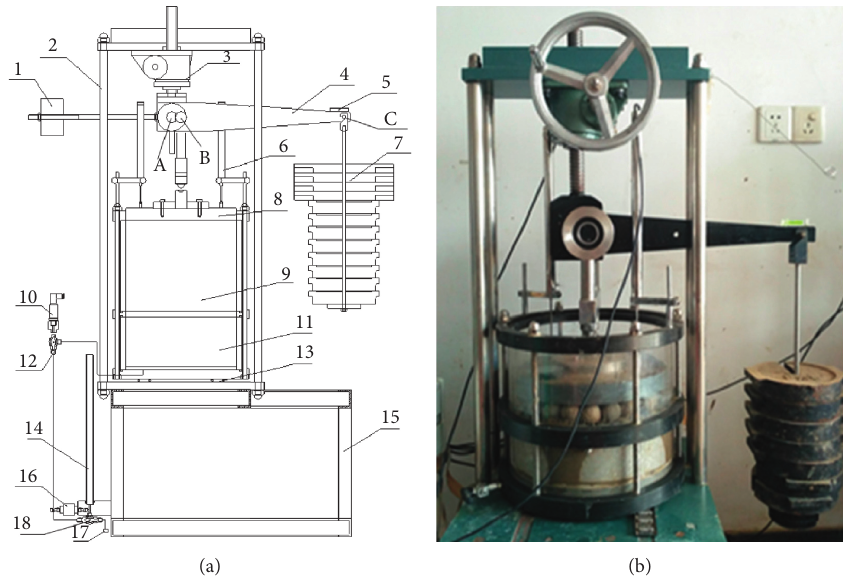
Figure 2: Mutual embedding testing apparatus: (a) design sketch; (b) photo picture. Note: different parts in (a) are numbered as follows: 1- counterforce weight; 2-counterforce framework; 3-leverage leveling structure; 4-leverage; 5-balancing bubble; 6-displacement sensor; 7- weights; 8-displacement plate; 9-upper contain; 10-pore pressure sensor; 11-lower container; 12-the first three-way valve; 13-ball row; 14- burette; 15-table support; 16-differential pressure sensor; 17-water vent; 18-the second three-way valve; A-pivot; B-force-bearing point; C- loading